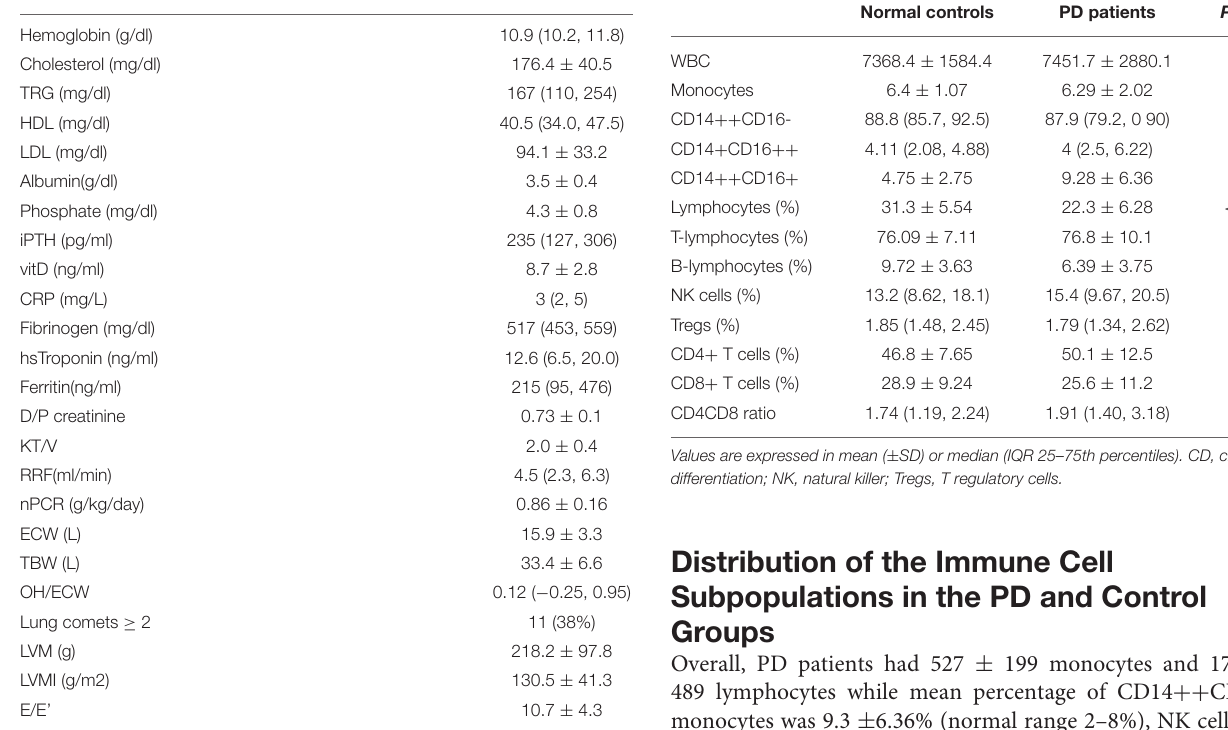
TABLE 1 | Laboratory, lung ultrasound, bioimpedance and echocardiographic data of the PD patients. Hemoglobin (g/dl)